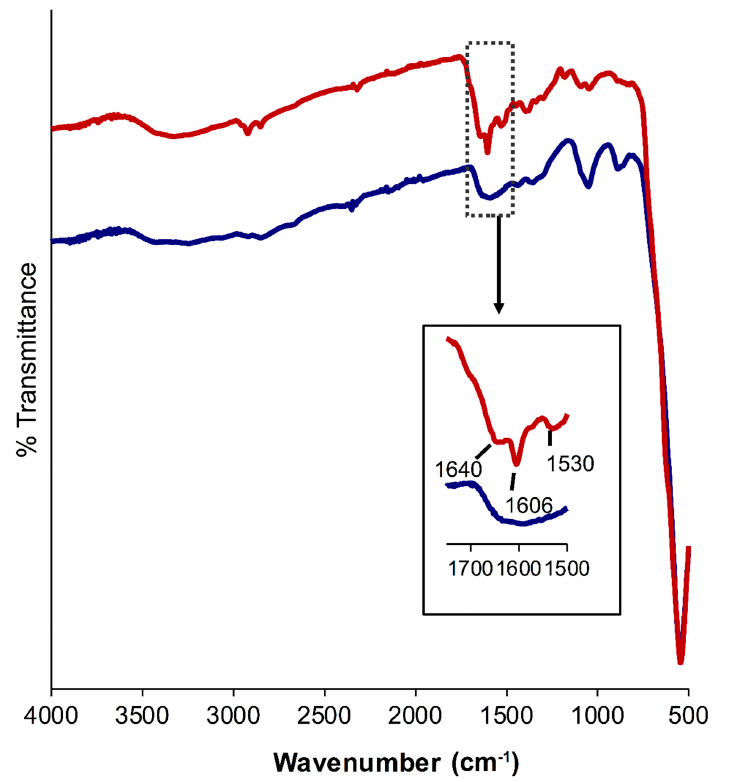
Figure 5. FTIR of MNP-1 (blue) and after reaction with folic anhydride to yield MNP-4 (red). Inset: detail of the significant peaks in the C = O stretching region. detail of the significant peaks in the C = O stretching